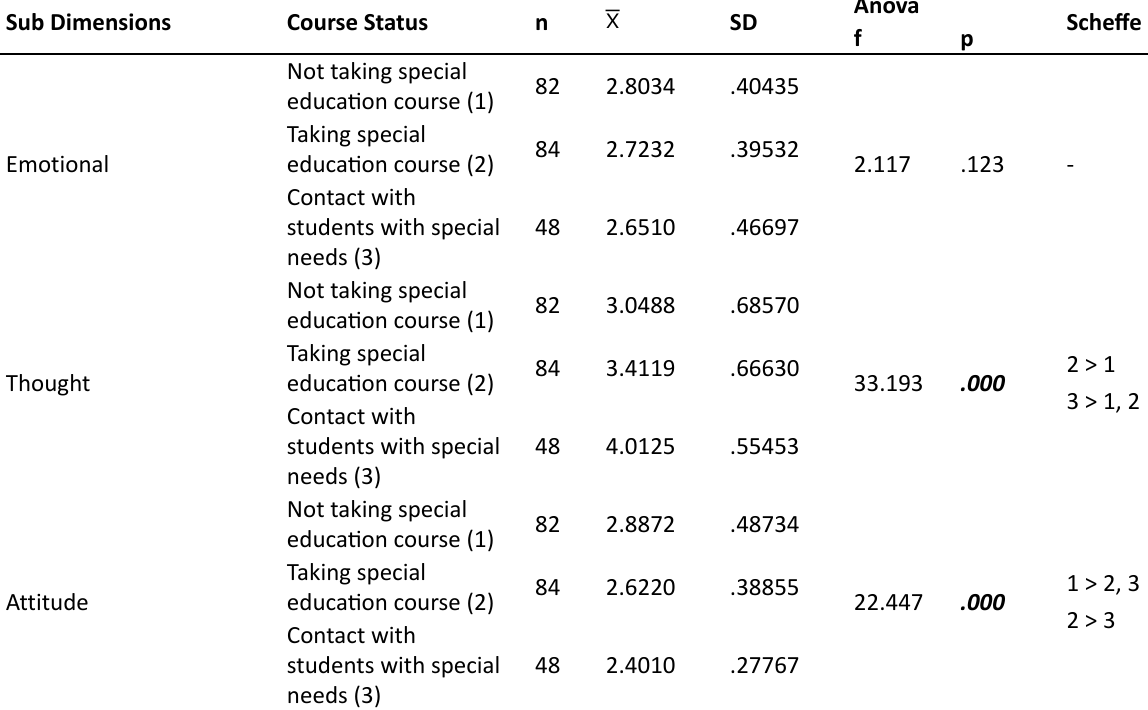
Table 3. One Way Anova Results by Taking Special Education Course and Contacting Students with Special Needs Sub